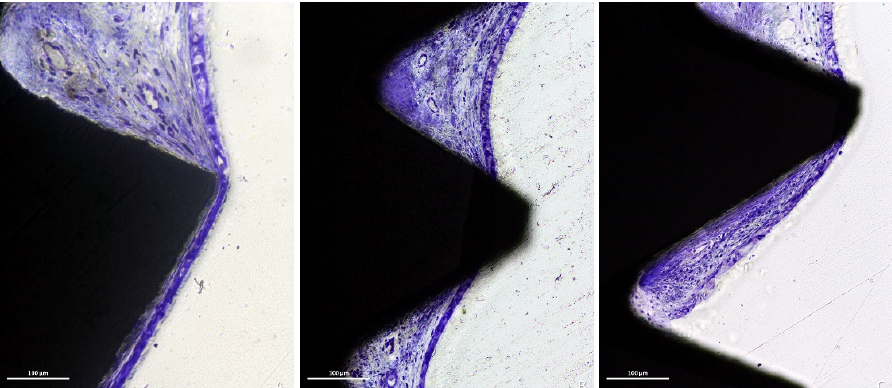
Figure 8. Photomicrographs of ground sections. ( A ), thinned mucosa around the last threads and the apex (at the bottom). ( B , C ), the sinus mucosa surrounding the exposed threads generally pre- sented lower amount of inflammatory infiltrated compared to the apical exposure. ( A – C ), Toluidine blue stain.